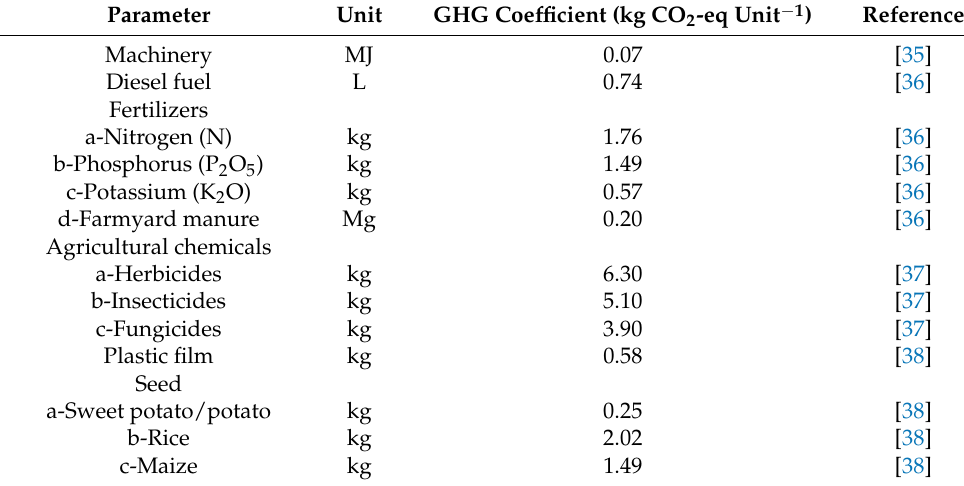
Table 3. The GHG emissions coefficient of agricultural